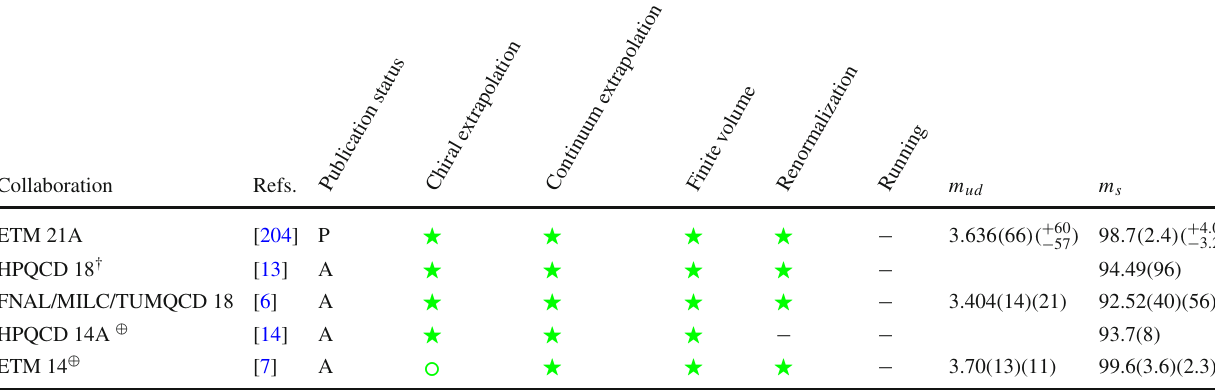
Table 7 N f = 2 + 1 + 1 lattice results for the masses m ud and m s